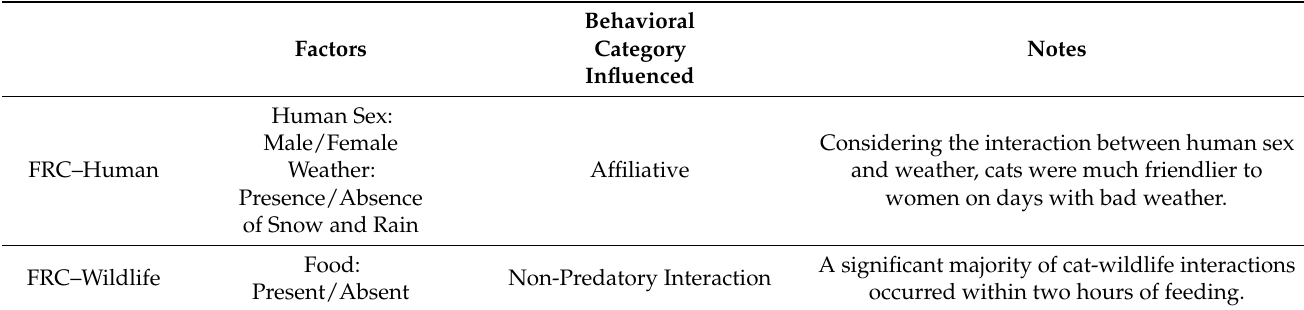
Table 3. Factors influencing FRC interspecific social behavior. The species involved, factors, behav- ioral category influenced, and a summary of each influence is